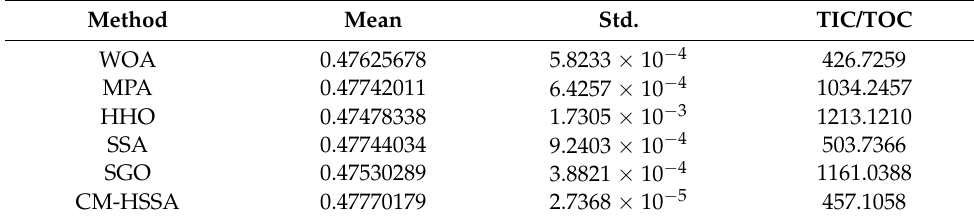
Figure 22. Iterative trajectories of six algorithms for Problem 2. Table 6. Comparison of optimization results for Problem 2. Table 6. Comparison of optimization results for Problem 2.